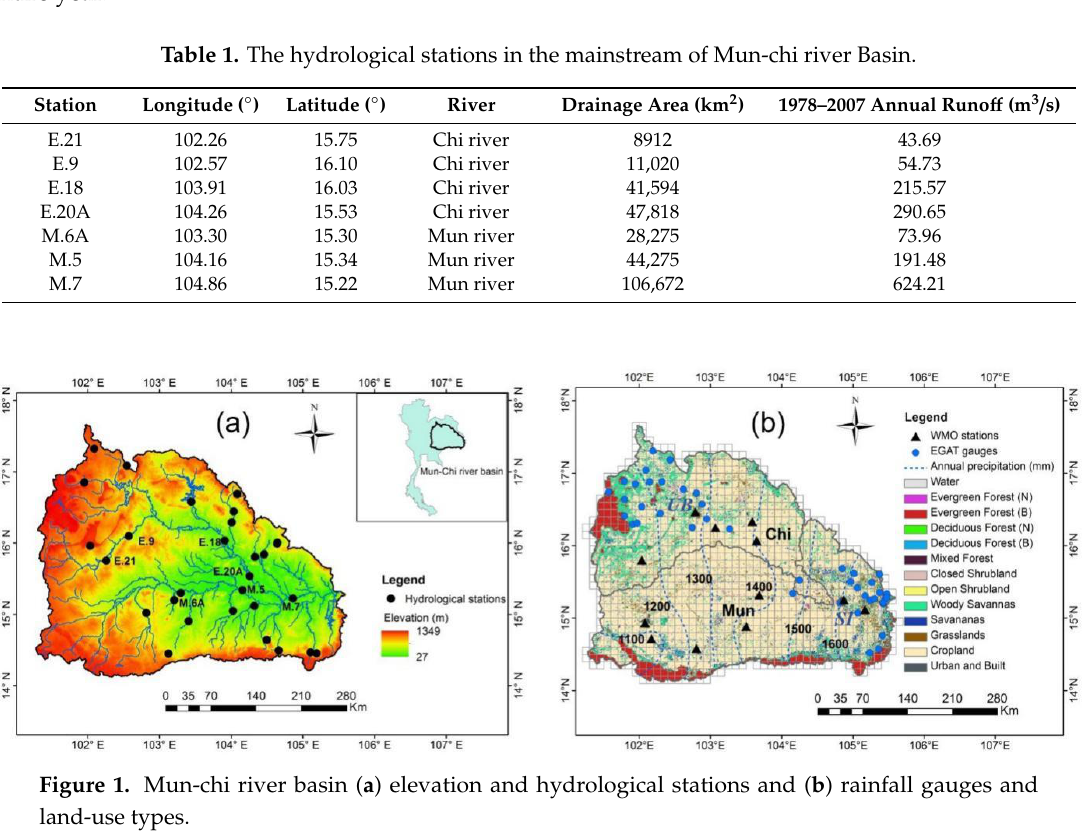
Figure 1. Mun-chi river basin ( a ) elevation and hydrological stations and ( b ) rainfall gauges and land-use types.